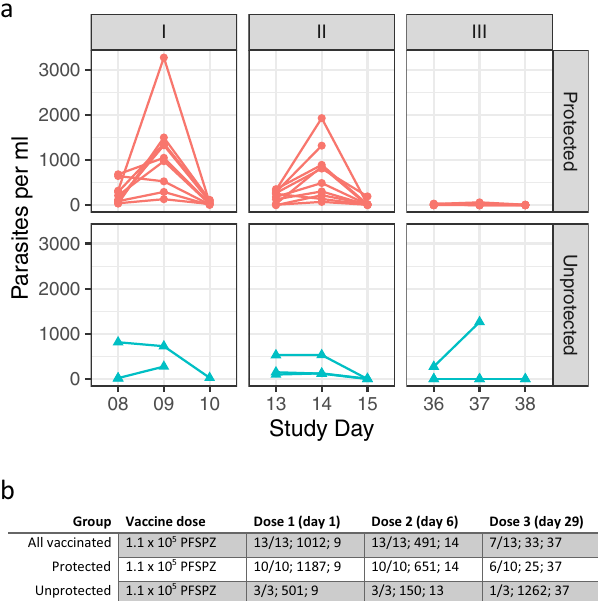
Fig. 3 Parasitemia during immunization phase. a Parasitemia (parasites/ ml) was estimated by quantitative PCR during the immunization phase after immunizations 1, 2, and 3. Individual parasitemia levels are shown. Red circles: vaccinated group (protected); turquoise triangles: vaccinated group (unprotected). During the fi rst vaccination period, one unprotected vaccinee missed visits of Study days 9 and 10 after immunization, two volunteers missed the visit on Study day 10 after immunization. At second immunization, one protected volunteer missed the visit on Study day 15. For the third immunization, one unprotected and one protected vaccinee missed the visit on Study day 38 after immunization. b Number of subjects positive per number injected, median peak parasite density among positives, and study day of median peak parasite density among positives after each dose of PfSPZ-CVac. Values are given for all vaccinated volunteers as well as separated by outcome of CHMI.